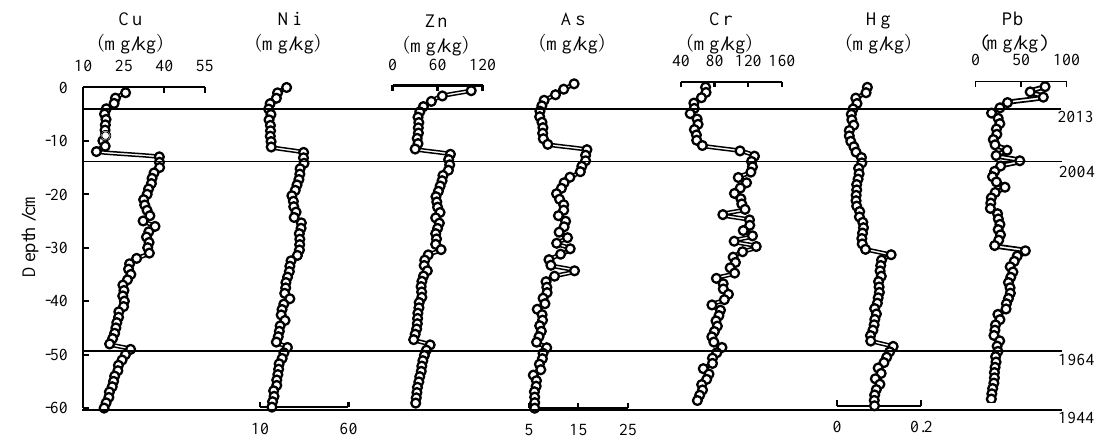
Figure 3. Heavy metal concentrations in the sediment core.